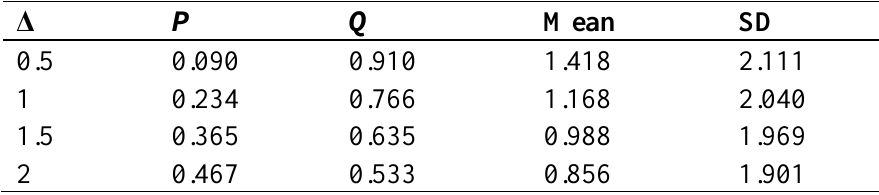
Table 4. Lead time estimates from Wu et al .